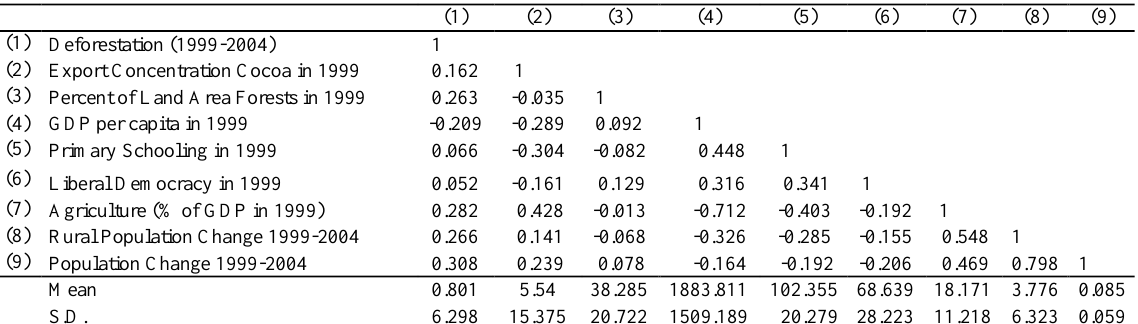
Table 5. Correlation Matrix, Means, and Standard Deviations for 5-Year Deforestation Ending 2004